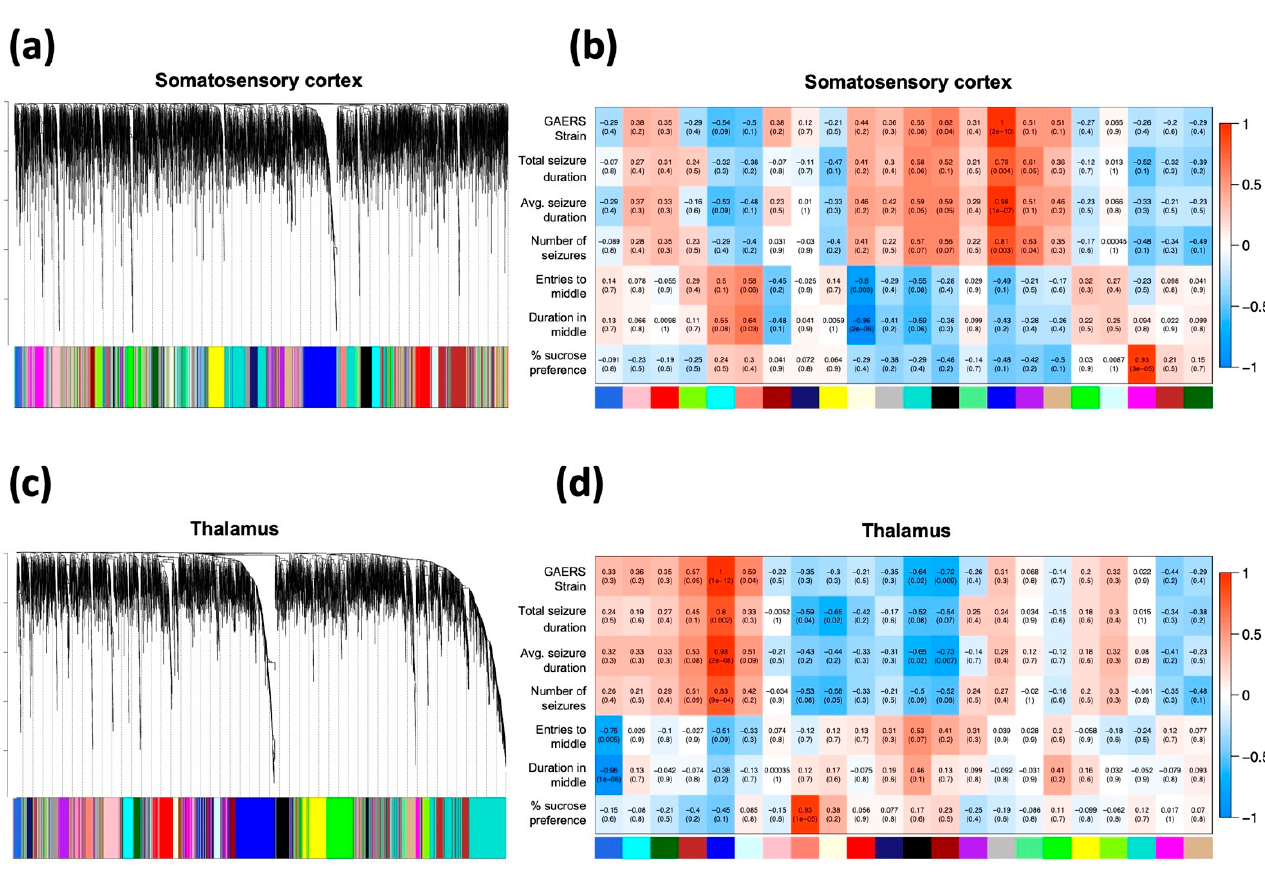
Figure 4. WGCNA of integrated multi-omic data from somatosensory cortex and thalamus. Left: Hierarchical cluster dendrogram of ( a ) SCx and ( c ) thalamic correlation networks. Each vertical line in the dendrogram represents a single protein/metabolite, with the arbitrarily assigned color of their respective modules at the bottom. Right: Heatmap of all modules ( x -axis) identified via WGCNA in ( b ) SCx and ( d ) thalamus and their corresponding Pearson correlation to phenotypic traits ( y -axis). Each block in the heatmap shows the direction (red: positive, blue: negative), strength (top coefficient) and significance (in brackets) of the Pearson correlation of the given module to the GAERS strain, seizure parameters, and behavioral outcomes.